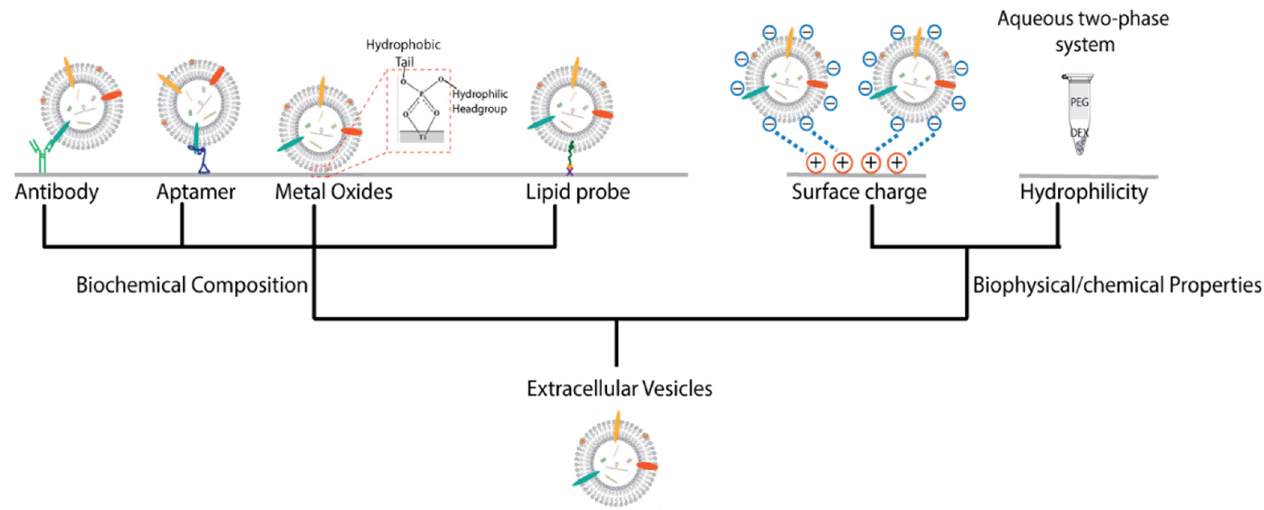
Figure 1. Isolation based on the surface characteristics of EVs. The EVs can be isolated by various affinity interactions including antibodies and aptamers for marker proteins, metal oxides for hy- drophilic phosphate heads of phospholipids and lipid probes for lipids on the membrane of EVs. Isolation also can be performed via the biophysical or chemical properties of EV membranes, such as surface charge and hydrophilicity.